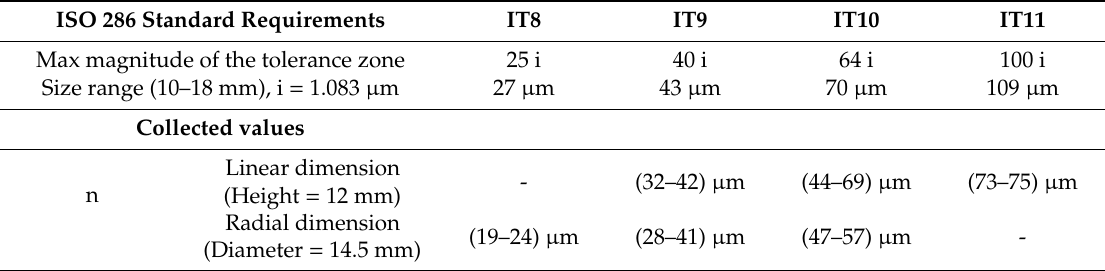
Table 9. International tolerance grades for the circular artifact.